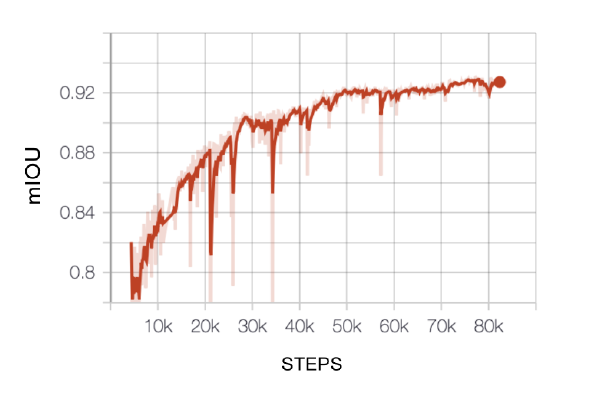
Figure 16. Evolution of mean IoU (mIoU) against the number of training steps (camera 0, St. Moritz, winter 2016–2017). Dark red curve represents a smoothed version of the original (light red)